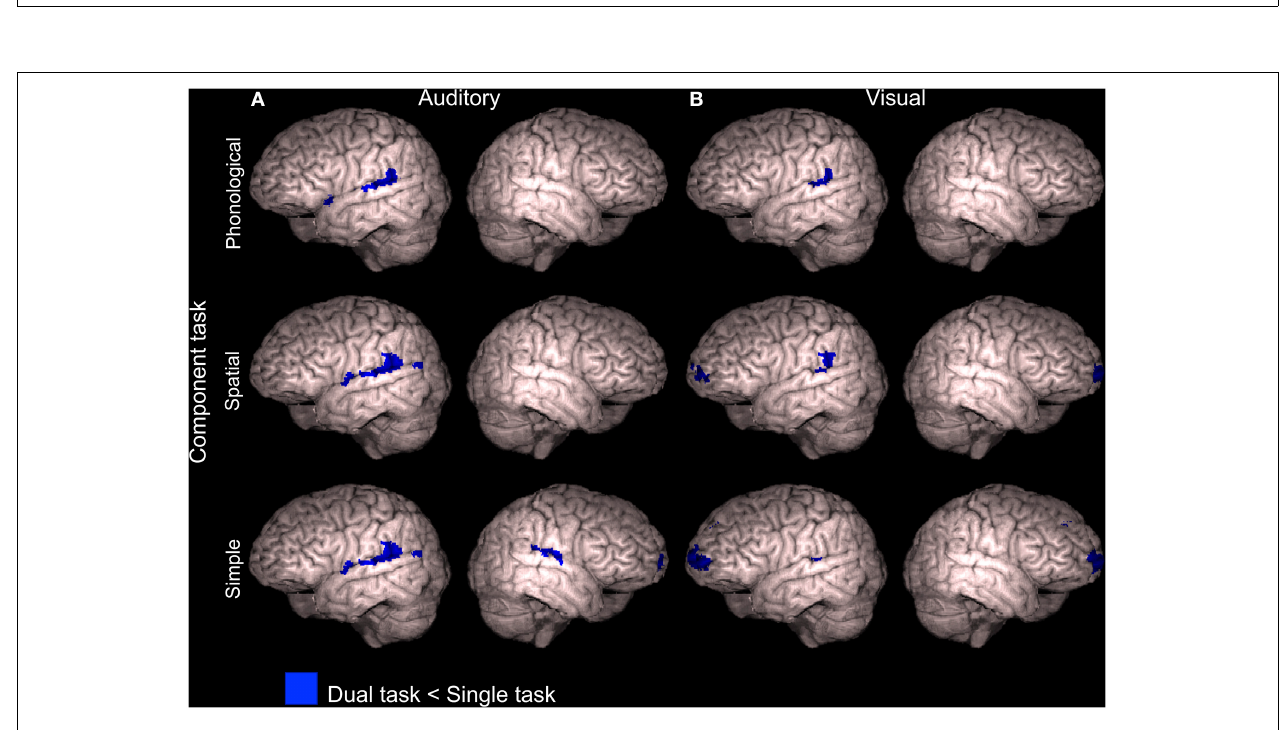
the present study in relation to both its auditory component task and its visual component task when performed separately in our previous study (Salo et al., 2013).